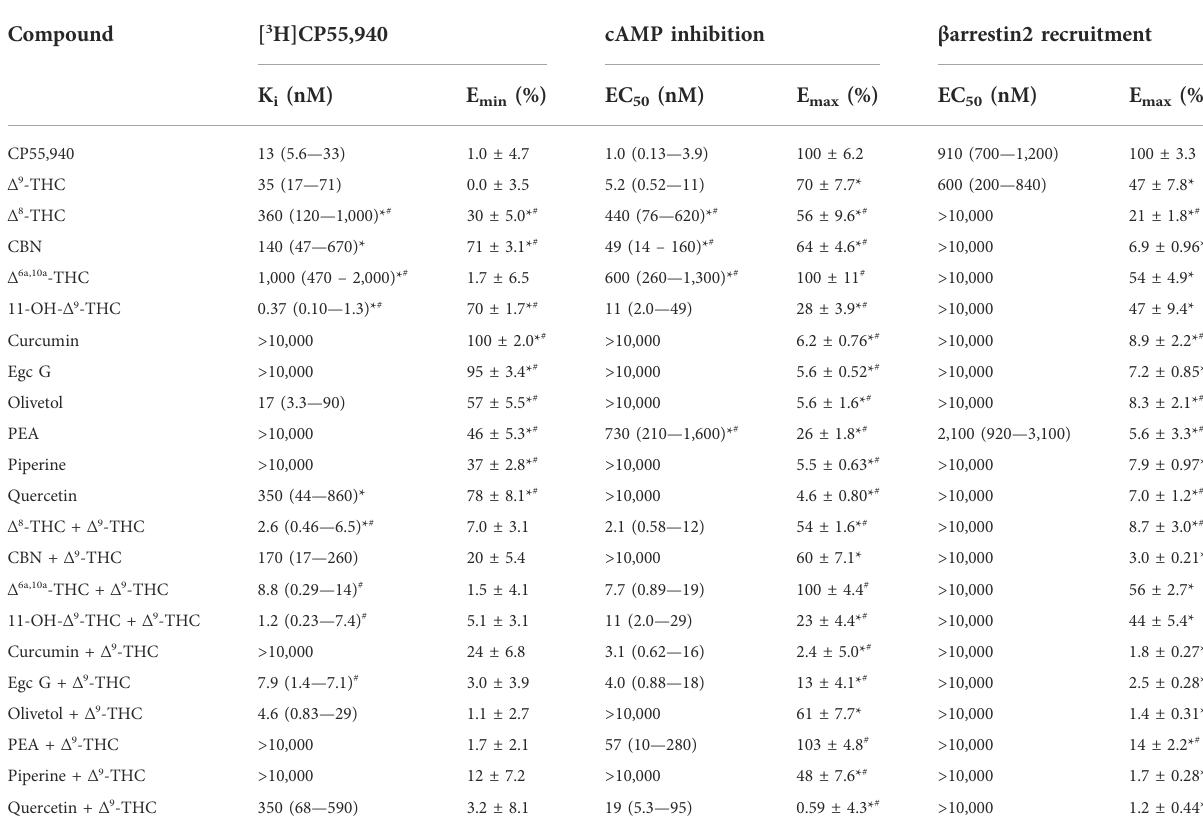
TABLE 1 Activity of compounds at hCB1R.